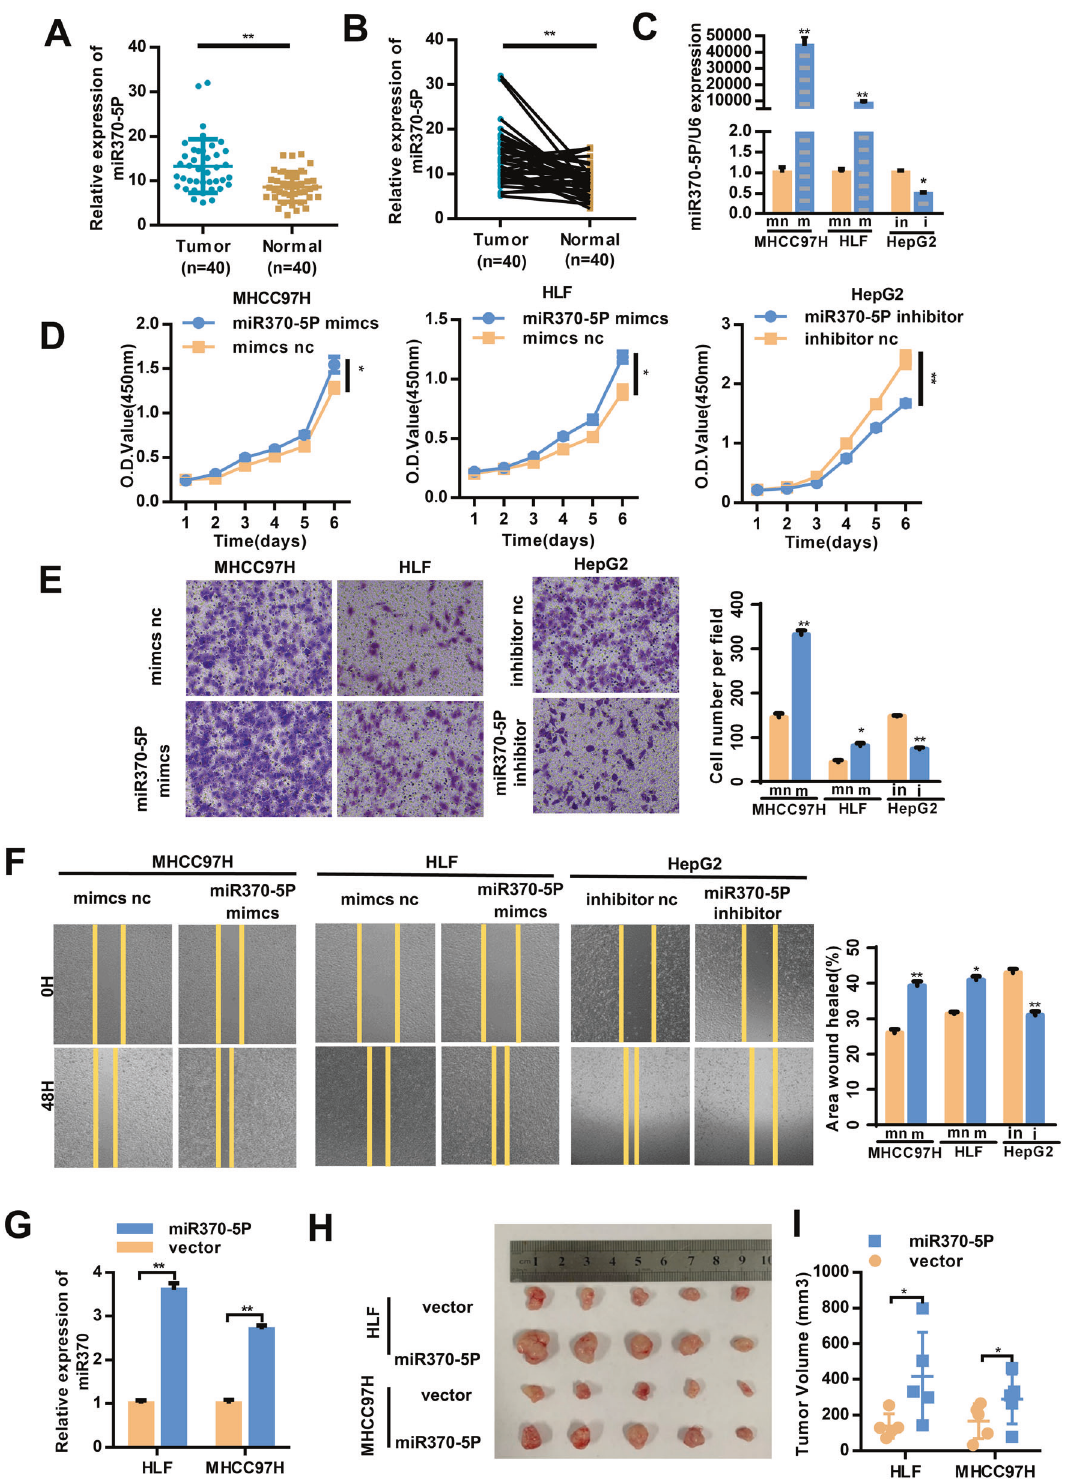
Fig. 5 miR-370-5P promoted the progression of HCC cells in vitro and in vivo. A , B The expression level of miR-370-5P in 40 TNBC tissues and their matched normal adjacent tissues was determined by qRT-PCR. C Overexpression and downregulation of miR-370-5P in hepatocellular carcinoma (HCC) cells using a miRNA-370-5P mimic or inhibitor, respectively, as measured by qRT-PCR. D miR-370-5P overexpression in MHCC97H and HLF cells promotes cell proliferation as measured by the CCK8 assay; downregulation of miR-370-5P in HepG2 cells inhibits cell proliferation as measured by the CCK8 assay. E The transwell assays. F The wound healing assays. G The expression levels of miR-370-5p were examined by qRT-PCR in HLF and MHCC97H cells with stable miR-370-5p overexpression. H , I HCC cells were subcutaneously injected into nude mice ( H ) and tumor volume were plotted ( I ). The data are represented as the mean ± SD, n = 3. * p < 0.05; ** p < 0.01; NS no signi fi cance. m miR370-5P mimcs, mn mimcs nc, i miR370-5P inhibitor, in inhibitor nc.